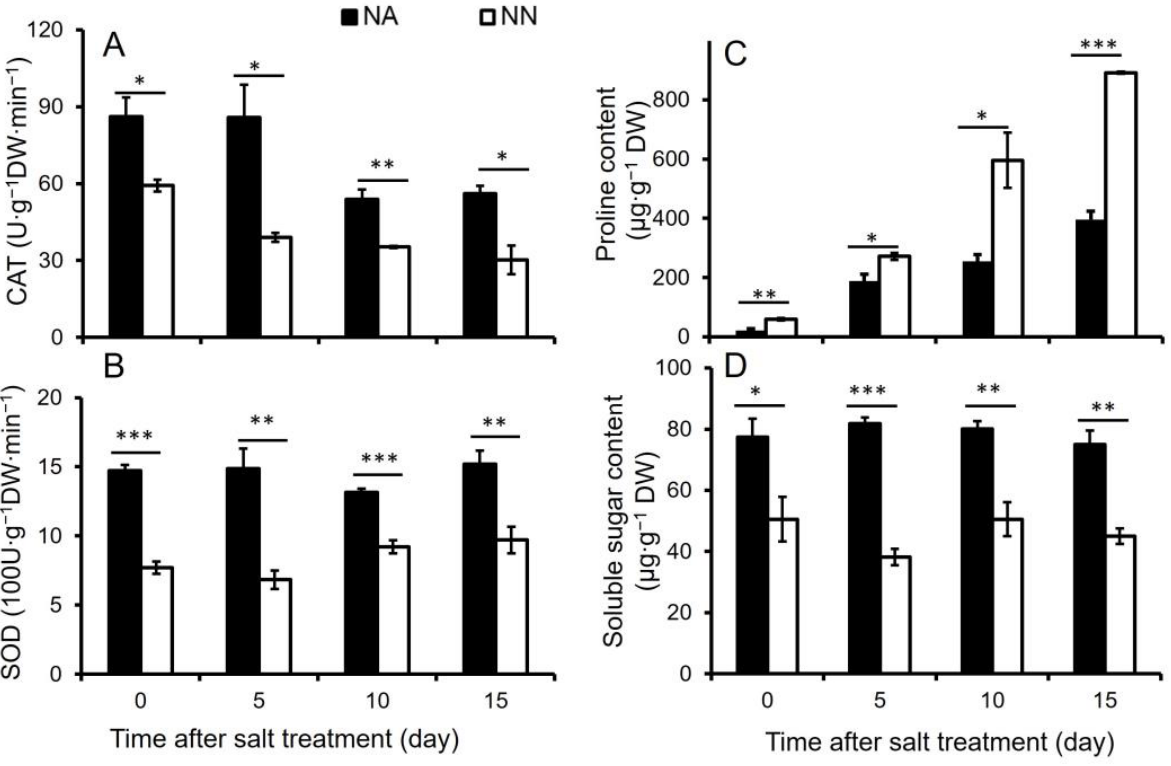
Figure 1. Effect of nodulation on catalase (CAT) activity ( A ), superoxide dismutase (SOD) activity ( B ), proline content ( C ), and soluble sugar content ( D ) in alfalfa roots under NaCl treatment. NA: alfalfa plants with active nodules; NN: alfalfa plants without nodules. Data are shown as means ± SE ( n = 5). *, **, and *** indicate a significant difference between NA and NN roots at p < 0.05, p < 0.01, and p < 0.001, respectively.